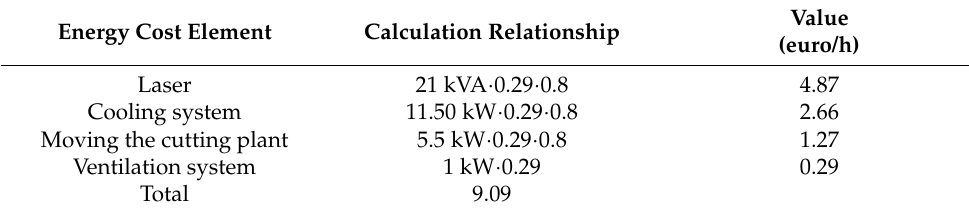
Table 11. Energy cost